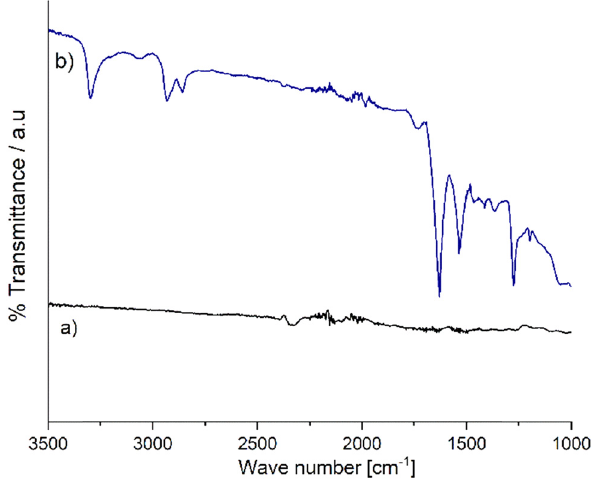
Figure A3: Cyclic voltammetry of ( i ) SPCE/PAni, ( ii ) SPCE/PAni/ AuNP, ( iii ) SPCE/PAni/AuNP/cMWCNT, and ( iv ) SPCE/PAni/AuNP/ cMWCNT/CAT biosensor in PBS 0.01 M in presence of 2 mM of H 2 O 2 at 20 mV s − 1 .